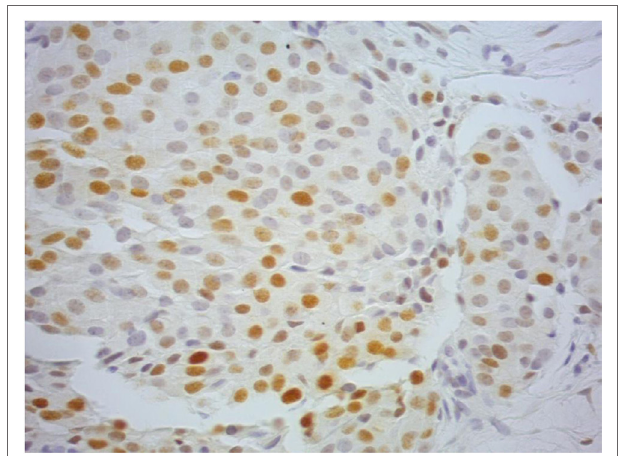
FigUre 1 | A Tanzanian ductal invasive carcinoma showing androgen receptor positivity in the nucleus of tumor cells, presenting different staining intensity (40 × magnification). This case globally was evaluated as 2 + .